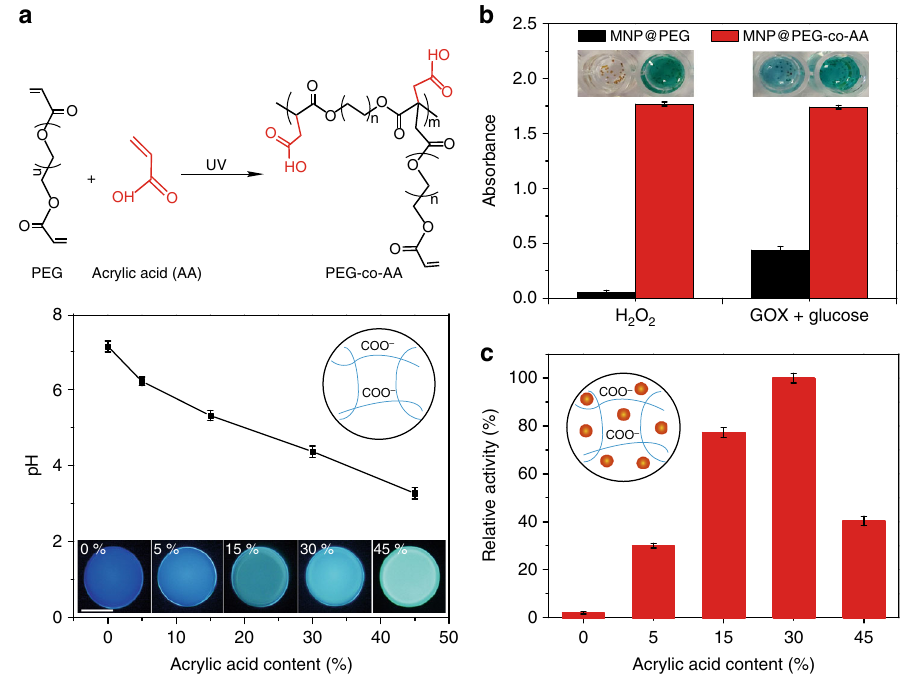
Fig. 4 AA-mediated pH microenvironments of PEG hydrogels. a Schematic representation of the copolymerization of AA with PEG and the pH of the microenvironments of poly(PEG-co-AA) hydrogel particles with different AA contents (0, 5, 15, 30, and 45%). The insets are their corresponding fl uorescent photographs. b Absorbance at 652 nm and visual colors of oxTMB catalyzed by MNP@PEG ( black bars ) and MNP@PEG-co-AA ( red bars ) in PBS (pH 7.0) using H 2 O 2 as a substrate or coupled with the GOX-catalyzed glucose oxidation reaction. c Relative activity changes of MNPs encapsulated in different PEG-co-AA with AA contents ranging from 0 to 45%. Assay conditions: MNP@PEG-co-AA was incubated with 1.25 mM H 2 O 2 and 43.75 μ M TMB in PBS (pH 7.0), and the absorbance was monitored at 652